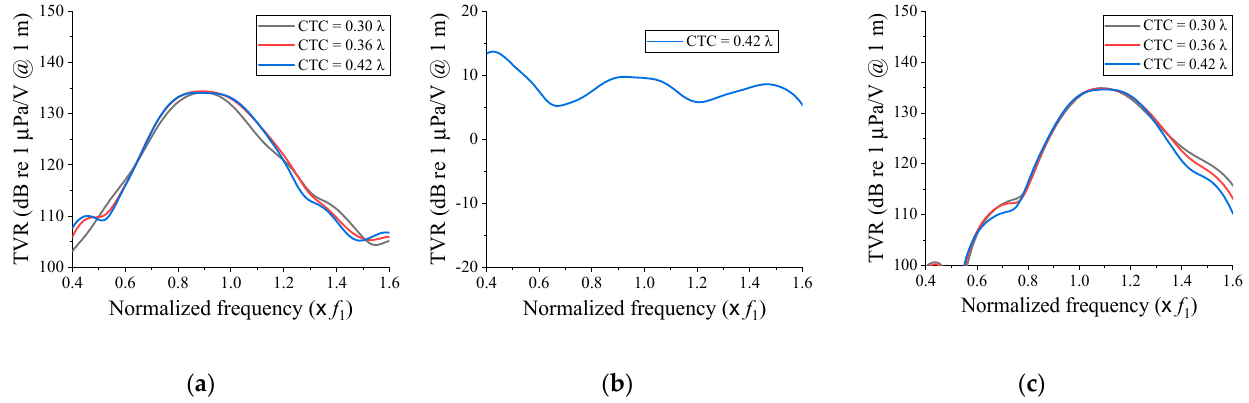
Figure 5. Comparison of the TVR spectra in relation to the center frequency difference and the CTC spacing when the polarity directions of Tx 1 and Tx 2 were opposite: ( a ) f 2 = 0.8 f 1 ; ( b ) f 2 = f 1 ; ( c ) f 2 = 1.2 f 1 .